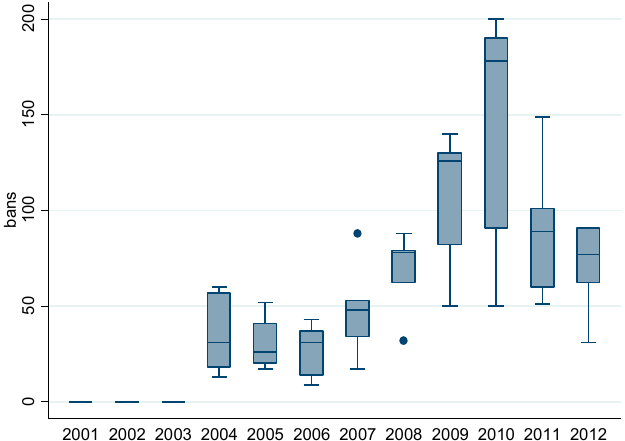
Figure 2. Bans in public housing by year*. Notes: *Ban legislation only covered public housing neighborhoods from 2004 onward; non-public housing neighborhoods had zero bans for all years.